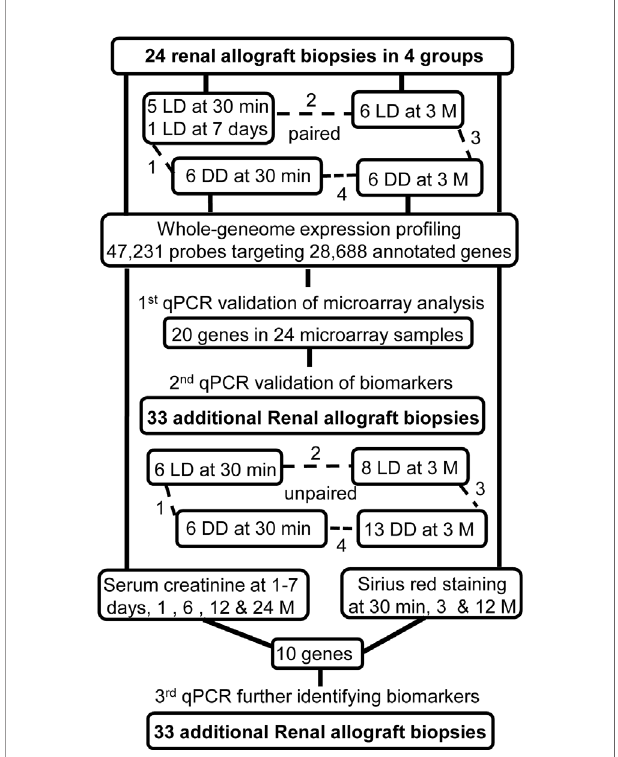
FIGURE 1 | Schematic picture illustrated the study